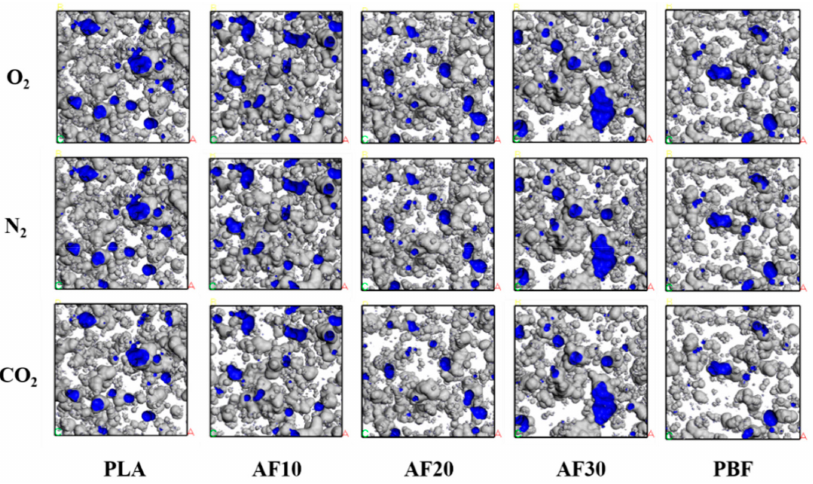
Figure 9. Schematic illustration of the free volume distribution of O 2 , N 2, and CO 2 in PLA, PBF, and blends (3000 ps).